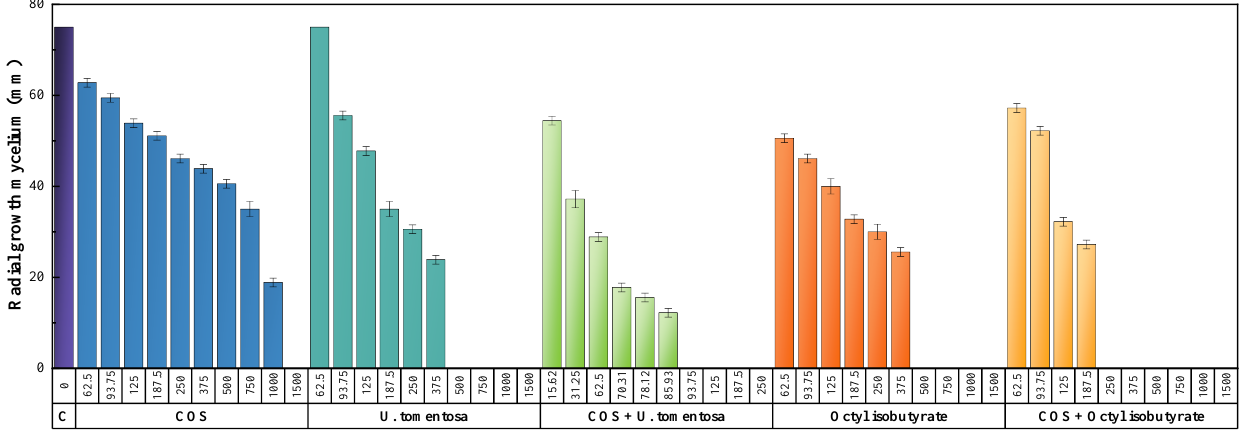
Figure 5. Inhibition of radial growth of the mycelium of V. dahliae in in vitro assays performed with different concentrations (in the 15.62 – 1500 µg·mL −1 range) of chitosan oligomers (COS), extract of U. tomentosa bark, the main constituent of the extract, and their respective conjugated complexes. Error bars represent standard deviations.